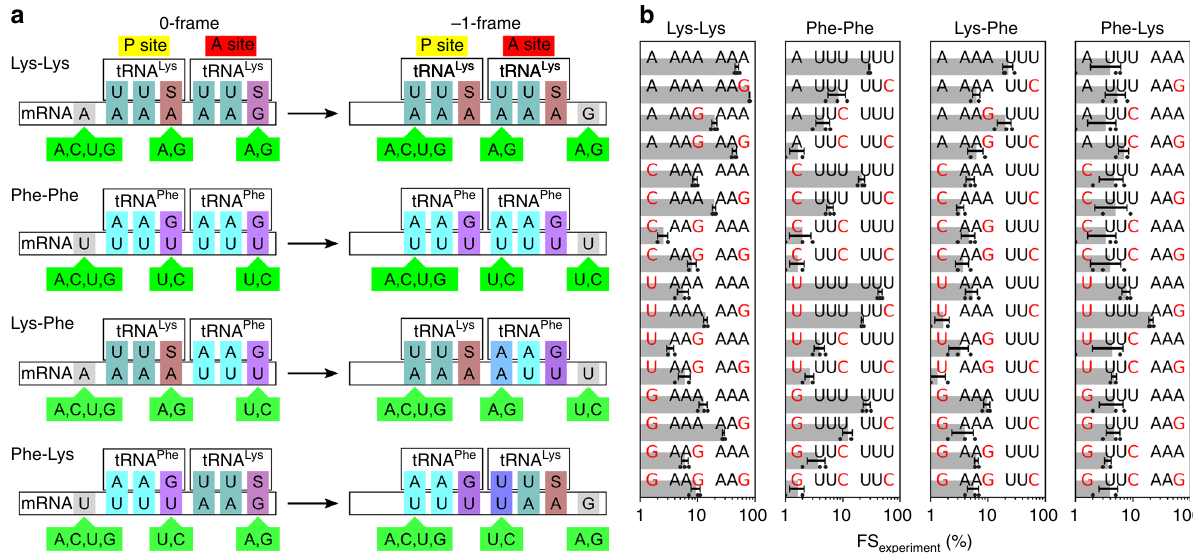
Fig. 1 Variants of the dnaX slippery sequence. a Mutations of the slippery sequence coding for Lys – Lys, Phe – Phe, Lys – Phe, and Phe – Lys. For each tRNA pair (upper row), the mRNA sequence (lower row) is shown for the 0-frame (left) and the − 1-frame (right) together with mutations (light green) that do not change the codon identity in the 0-frame, but affect frameshifting. The resulting codon – anticodon interactions at the slippery site codons are highlighted by colors, with Watson – Crick interactions highlighted in light and dark cyan; G·S and A·S pairs, where S denotes the modi fi ed nucleotide mnm 5 s 2 U (Supplementary Fig. 4), in dark purple and brown, respectively; the U·G wobble pair in purple; and A·A and U·U mismatches in different shades of blue. b FS (gray bars) for the indicated slippery sequence variants. Error bars denote the standard deviation from at least three independent experiments (dots, N ≥